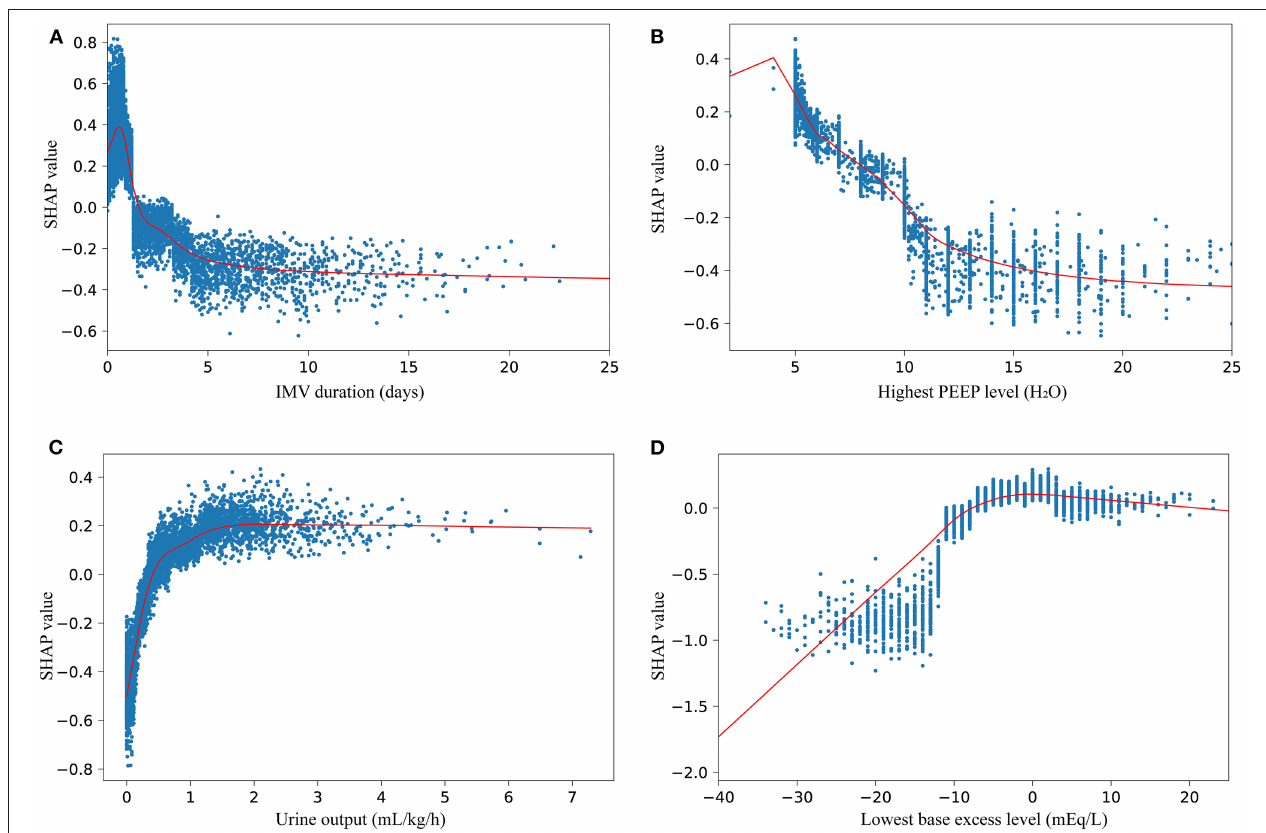
FIGURE 5 | SHAP dependency plots of IMV duration (A) , highest PEEP level (B) , urine output (C) , and lowest base excess level (D)